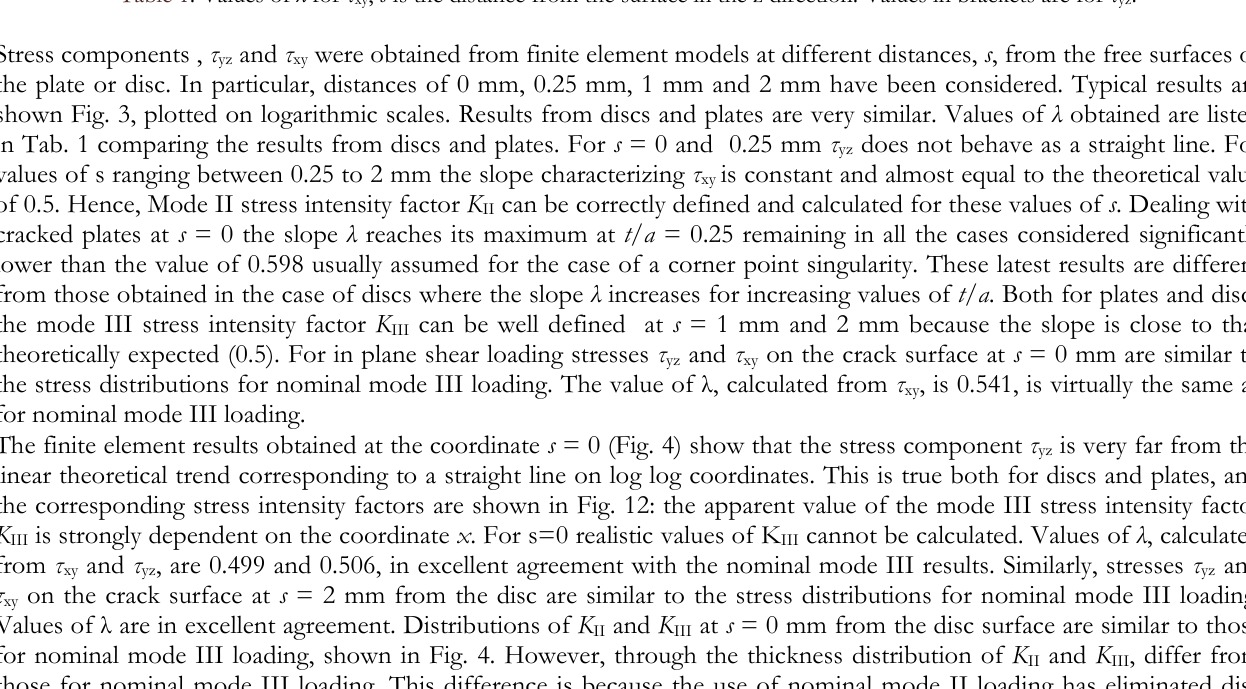
Table 1: Values of λ for τ xy , s is the distance from the surface in the z direction. Values in brackets are for τ yz